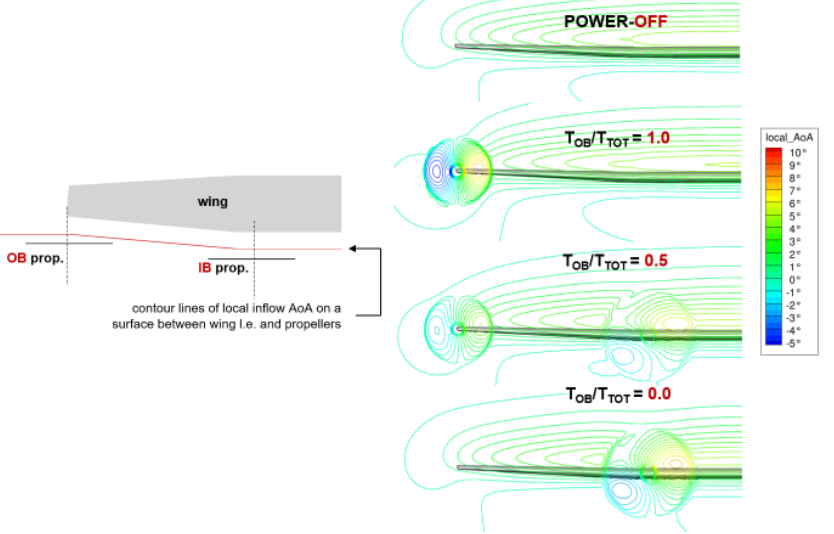
Figure 18. Effect of propeller swirl on local inflow angles of attack in cruise